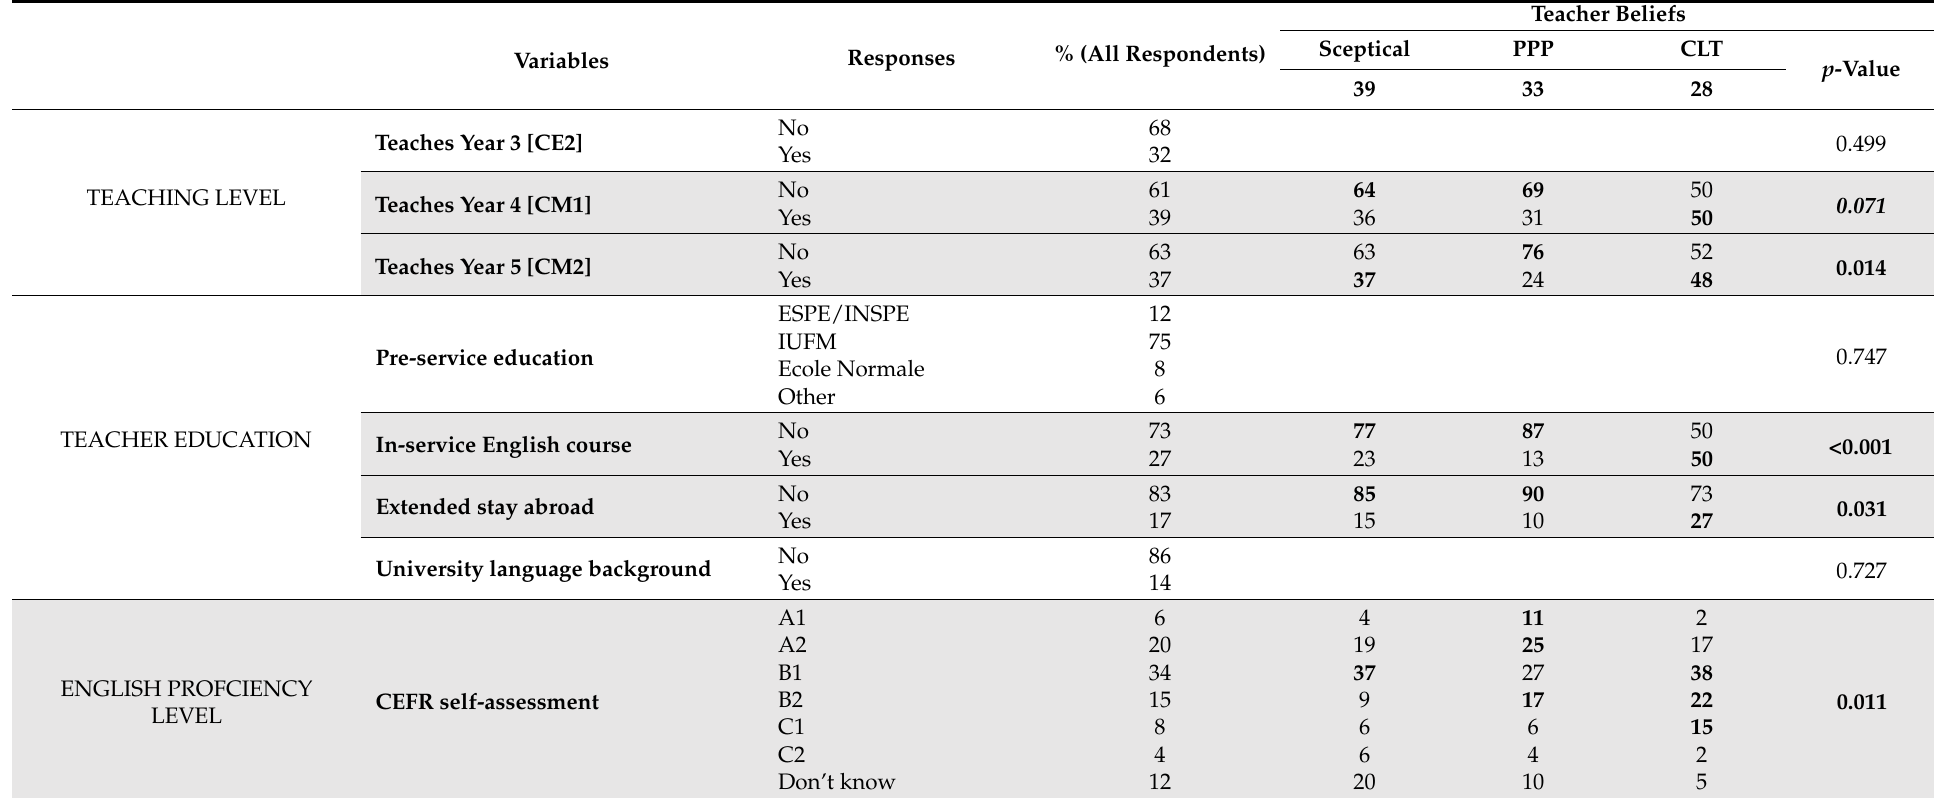
Table 4. Significant correlations between teacher beliefs and contextual variables.